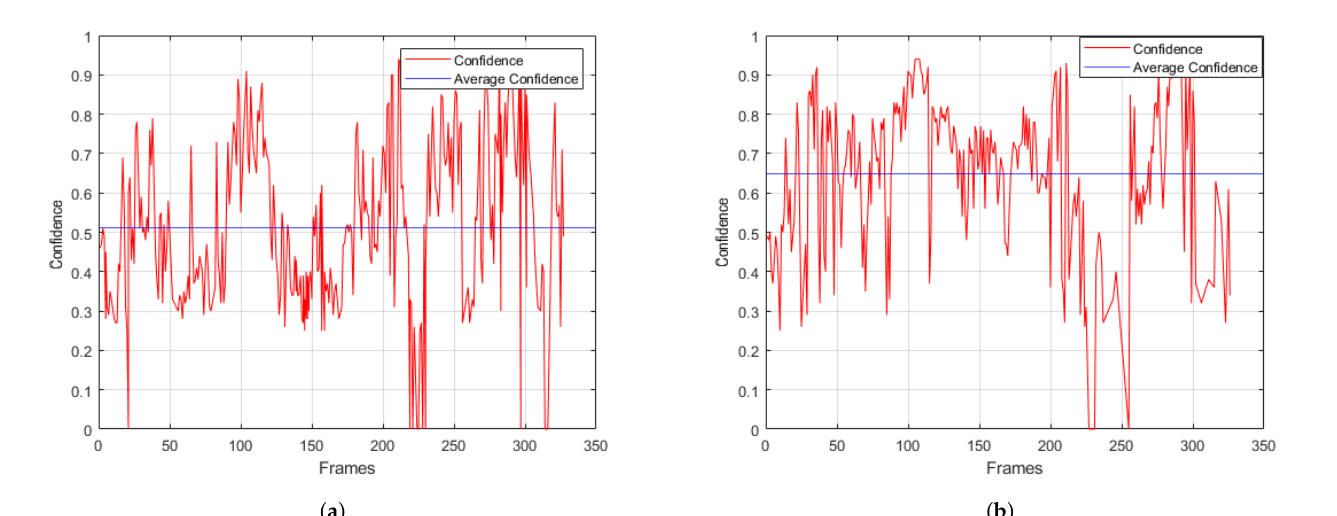
Figure 16. Stabilization graph of a paper box over 10 s: ( a ) small model; ( b ) xlarge